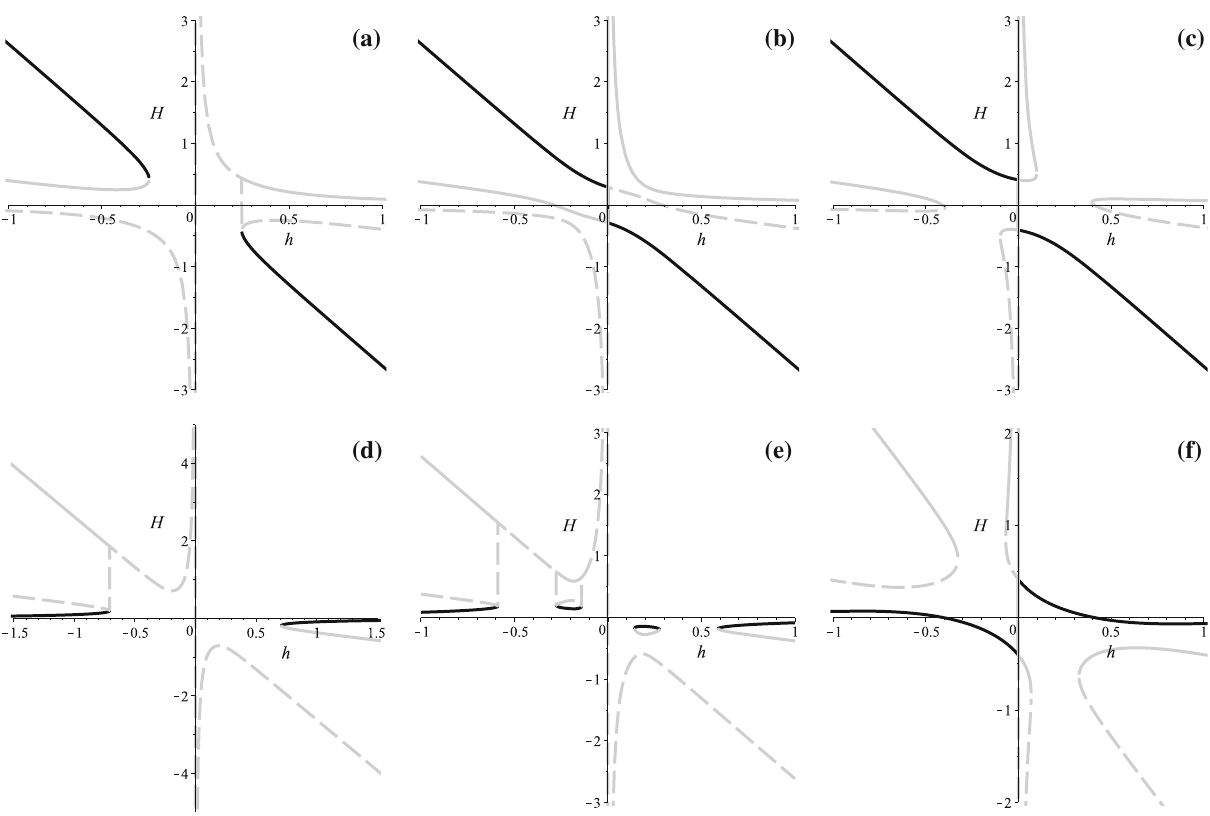
Fig. 1 H ( h ) graphs for the D = 3 case: α < 0, (cid:2) < 0 on a ; α < 0, (cid:2) > 0with α(cid:2) ≥ − 5 / 8on b andwith α(cid:2) < − 5 / 8on c ; α > 0, (cid:2) < 0 with α(cid:2) > − 1 / 8 on d and with α(cid:2) < − 1 / 8 on e ; α > 0, (cid:2) > 0 on f .